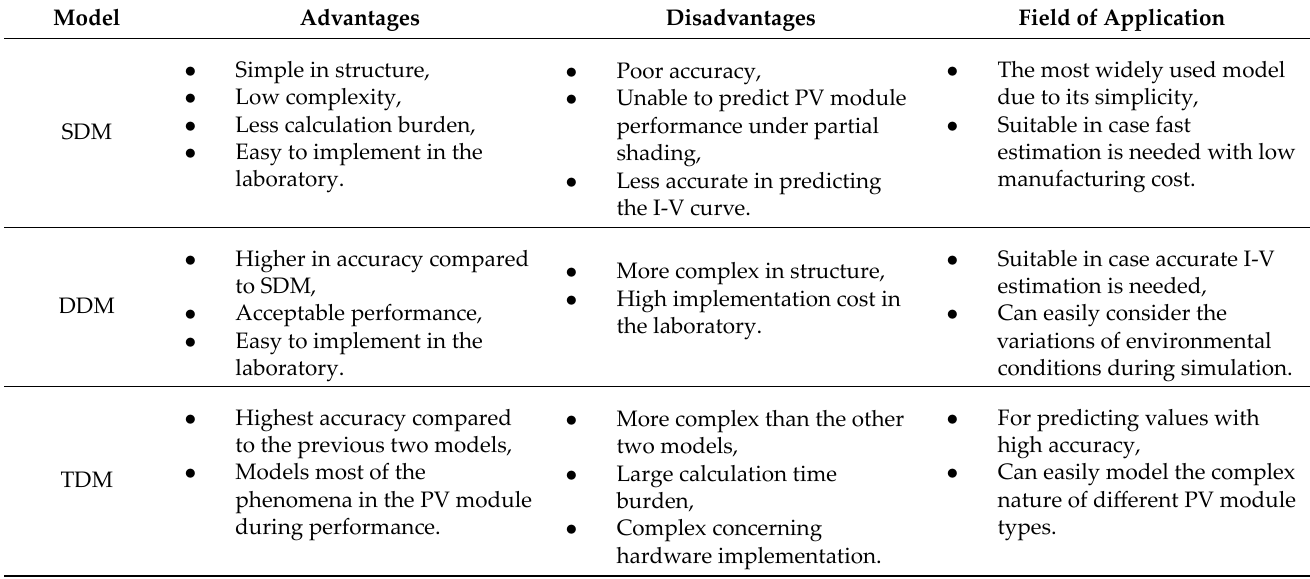
Table 1. Comparison between SDM, DDM, and